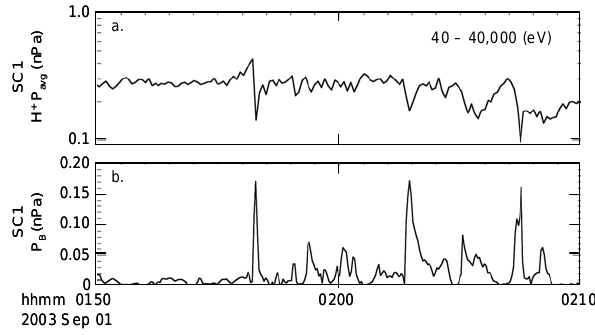
Fig. 6. (a) Proton pressure during the Figure 5 time interval. (b) Simultaneous magnetic pressure.